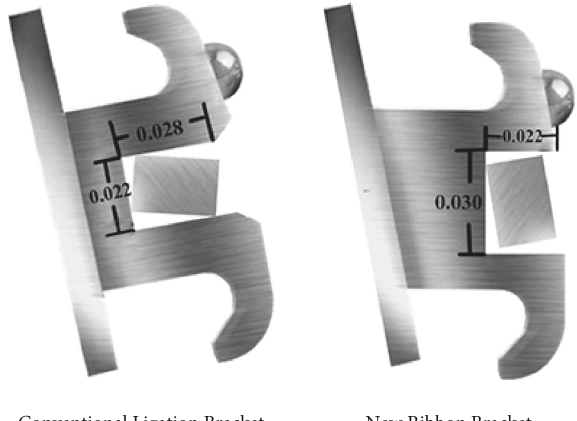
Figure 1: new ribbonwise labial bracket contains an occlusoapical slot of 0.030 ″ × 0.022 ″ , in contrast with the conventional ligation bracket which is 0.022 ″ × 0.028 ″ . The wire is 0.017 ″ × 0.025 ″ as a